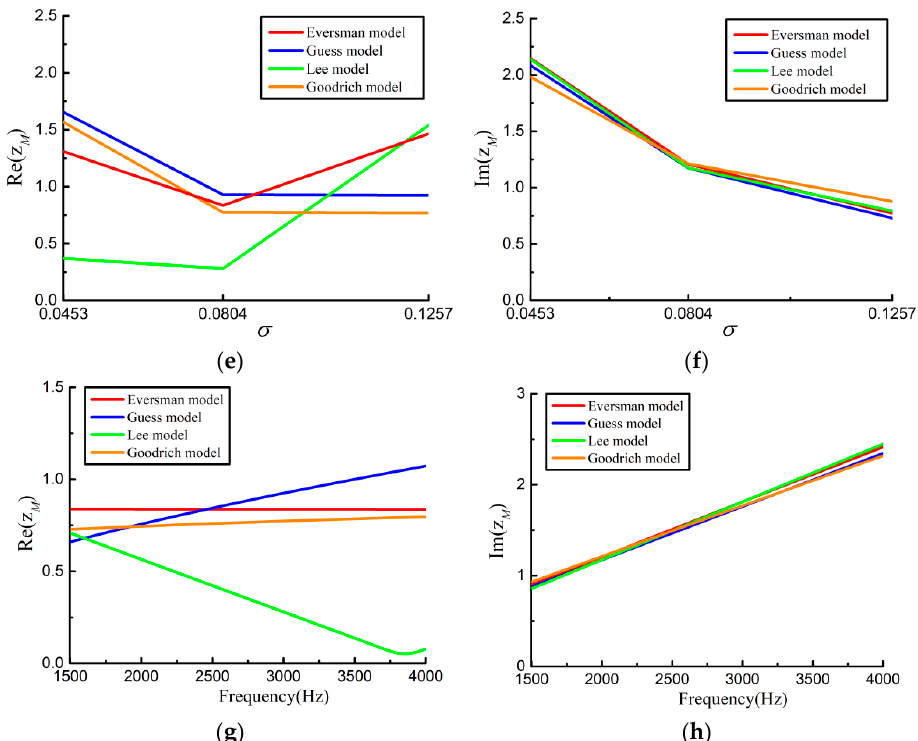
Figure 2. Comparisons of different impedance models. ( a ) Real part of impedance vs. Mach number; ( b ) imaginary part of impedance vs. Mach number; ( c ) real part of impedance vs. hole diameter; ( d ) imaginary part of impedance vs. hole diameter; ( e ) real part of impedance vs. perforation rate; ( f ) imaginary part of impedance vs. perforation rate; ( g ) real part of impedance vs. Frequency; ( h ) im- aginary part of impedance vs. frequency.